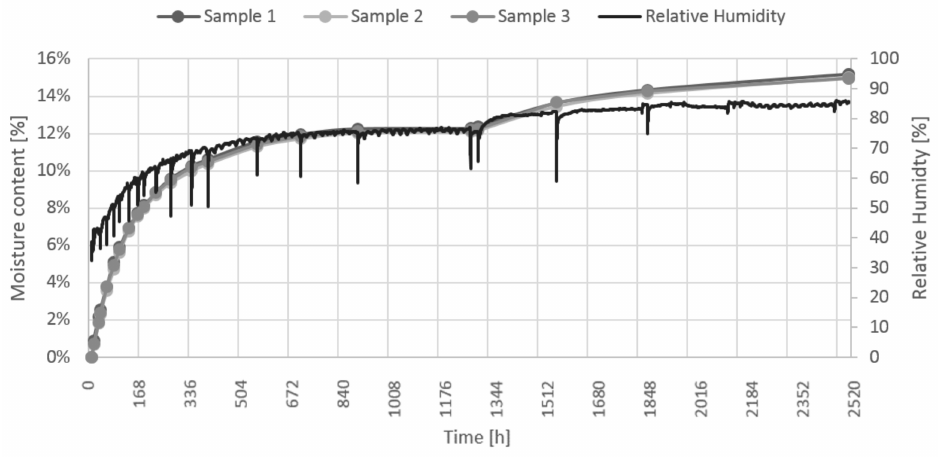
Figure 9. Evolution of moisture content over